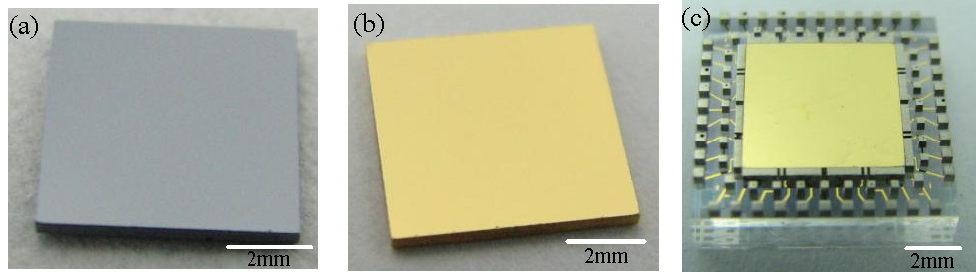
Figure 10. (a) Optical photograph of one silicon proof mass released made through DRIE. (c) photograph of a diced bottom stator with a proof mass